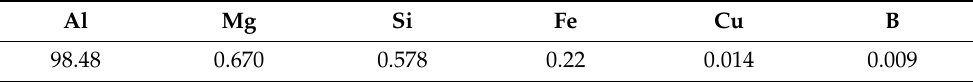
Table 1. The chemical composition of the investigated aluminum alloy wires (in wt.